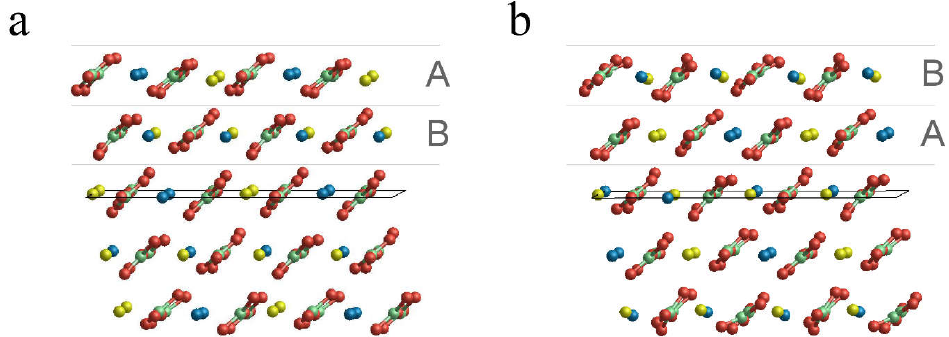
Figure 3. Optimized structure of the (10.4) slab of dolomite cut from the bulk structure SC4895. ( a ) and ( b ) are the two possible terminations for the surface. The slab is composed of a sequence of equal layers (… ABABA …). Ca : blue, Mg : yellow, C : green and O : red.